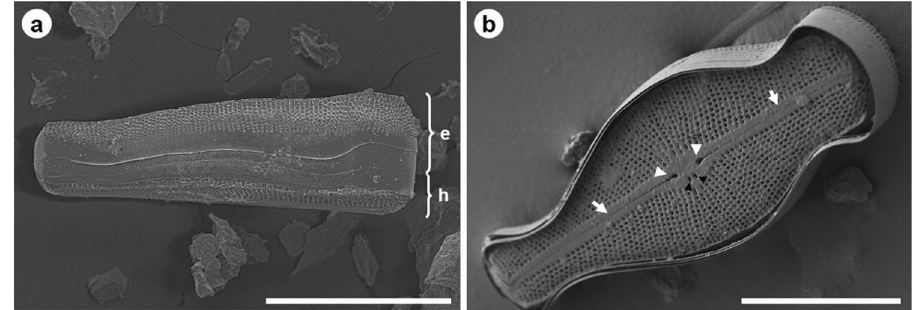
Figure 1. SEM images of D. geminata frustule: ( a ) girdle view (e – epivalve, h – hypovalve); ( b ) valve view. Note the presence of the apically oriented slit ( arrows ). The raphe was composed of two branches and two expanded pores. The external central raphe endings mark the extent of the central nodule ( white arrowheads ). The two closely located pores represent an opening of the stigmata ( black arrowheads ). Scale bars: 40 µ m ( a , b